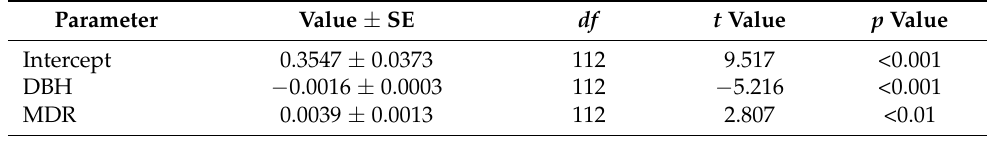
Table 12. Parameter estimates of the best candidate by model 3, Table 11.